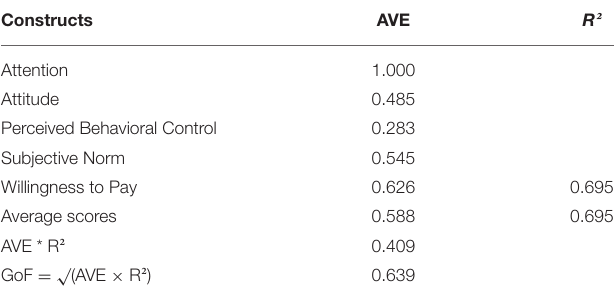
TABLE 7 | Calculation of GoF